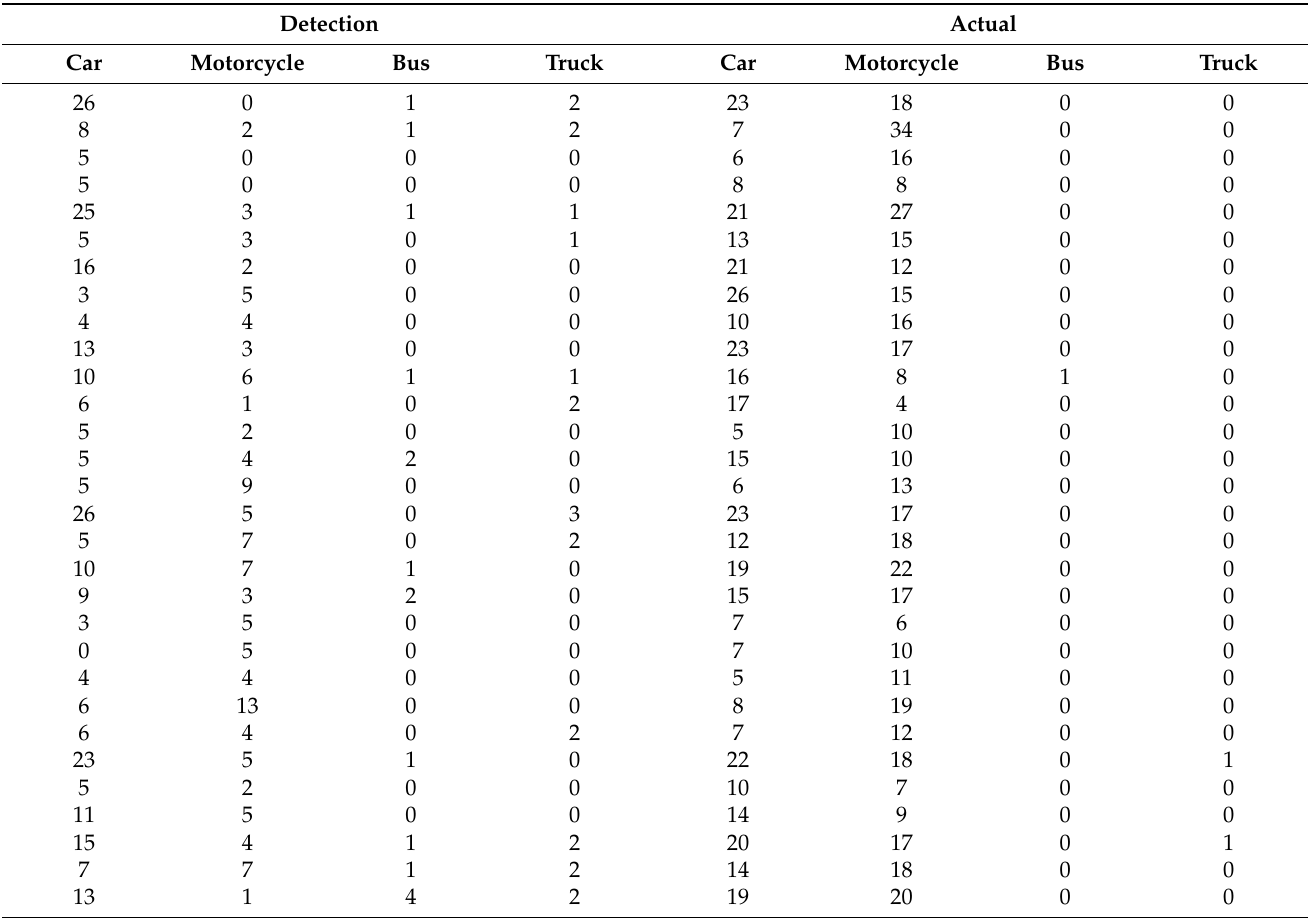
Table 13. Comparison between detection and actual result on Merdeka-Aceh